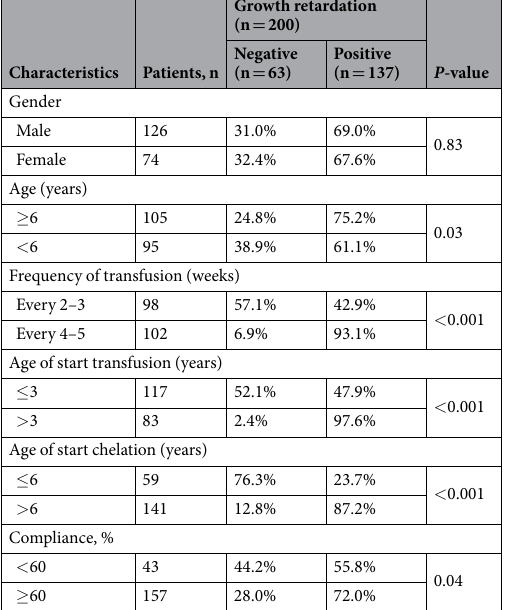
Table 3. Association between growth retardation and each of the demographic, frequency of transfusion, age of start transfusion, Age of start chelation, compliance.